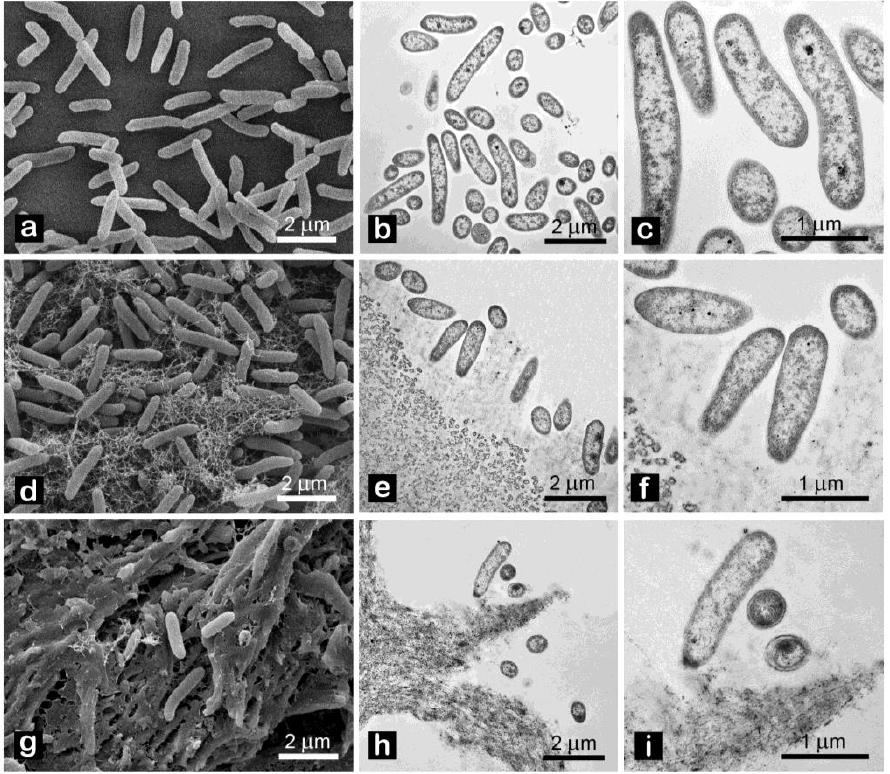
Figure 8. Pto morphology after exposure for 12 h to: tap water (( a ) SEM, ( b , c ) TEM); 1% w/v CNC-CH ( d ) SEM, ( e , f ) TEM); 1% w/v CNC-EN ( g ) SEM, ( h , i ) TEM). Measurements of intracellular ROS by DCFH-DA cytofluorimetric readings clearly showed that CNC did not generate oxidative stress in the bacterial cells, since the obtained values after 12 h were comparable to the negative control (sterile deionized water—SDW), while the positive control (H 2 O 2 ) was ten-fold higher (Figure 9).